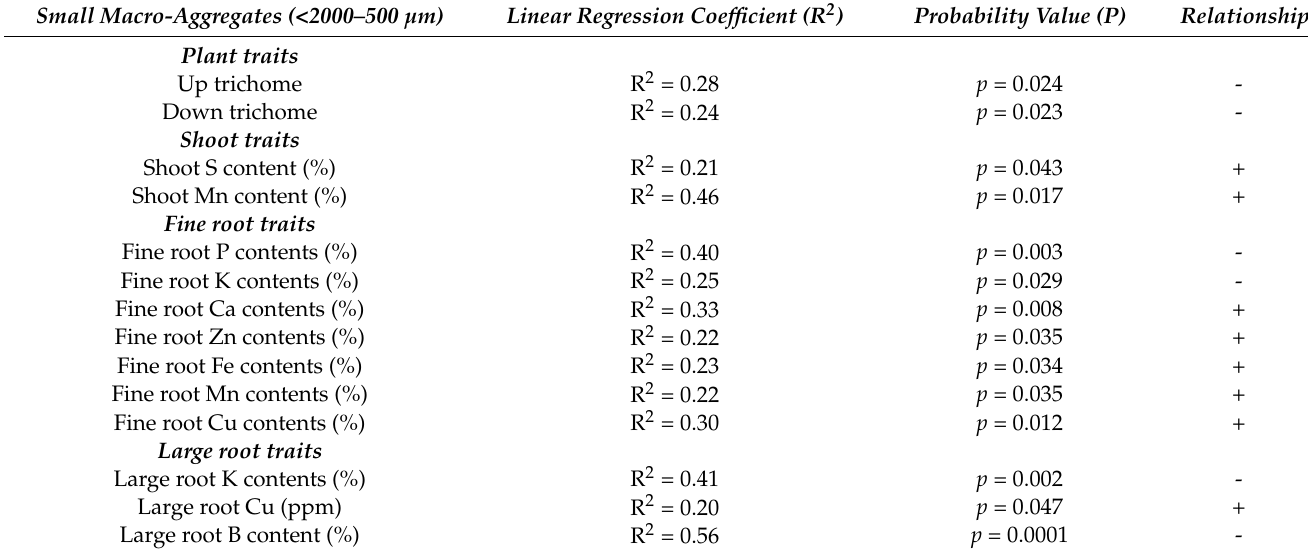
Figure 4. The relationship of organic carbon contents (%OC) of soil small macroaggregates with plant traits as determined by the linear regression ( a – n ). Only significant ( p < 0.05 ) relationships are plotted. The abbreviations are LR (large roots), FR (fine roots), Sht (shoot), LAdTri (leaf adaxial trichome density), and LAbTri (leaf abaxial trichome density). The trichome density was number of trichomes per 0.29 cm 2 of soybean leaf area. Table 2. Relationship between abundance of small macroaggregates (<2000–500 µ m) and plant